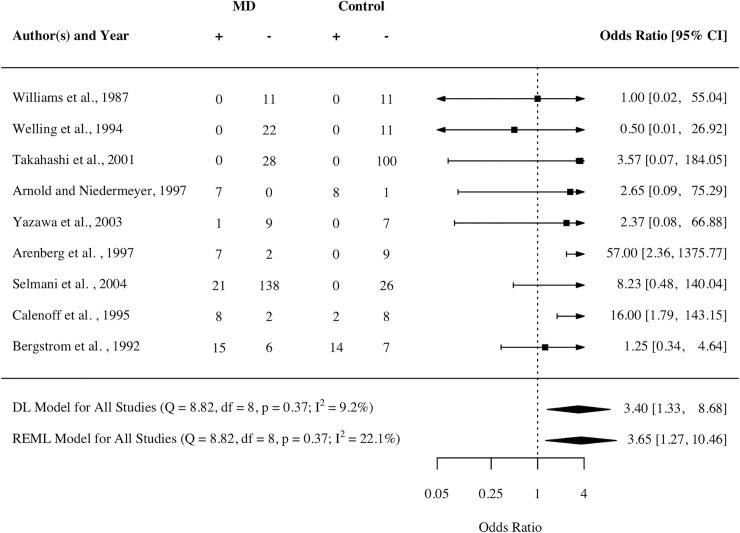
Odds of MD given evidence of CMV infection.The 95% C.I. for the OR obtained in each study down the page is represented by the confidence interval across the page, and the exact values corresponding to the interval are presented on the RHS. The +0.5 values reflect the Anscombe-Haldane corrected data. The overall effects obtained by pooled REML and DL inverse-variance estimators respectively are indicated by the solid black diamonds at the bottommost part of the figure, with the respective Cochran’s Q and Higgin’s I2 heterogeneity statistics presented alongside.